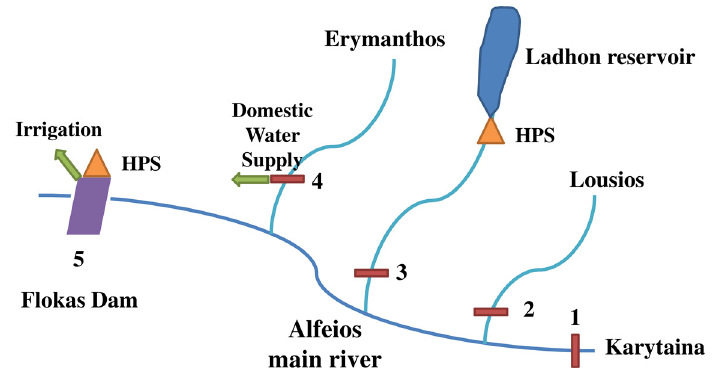
Figure 1. The simplified schematics of the Alfeios river